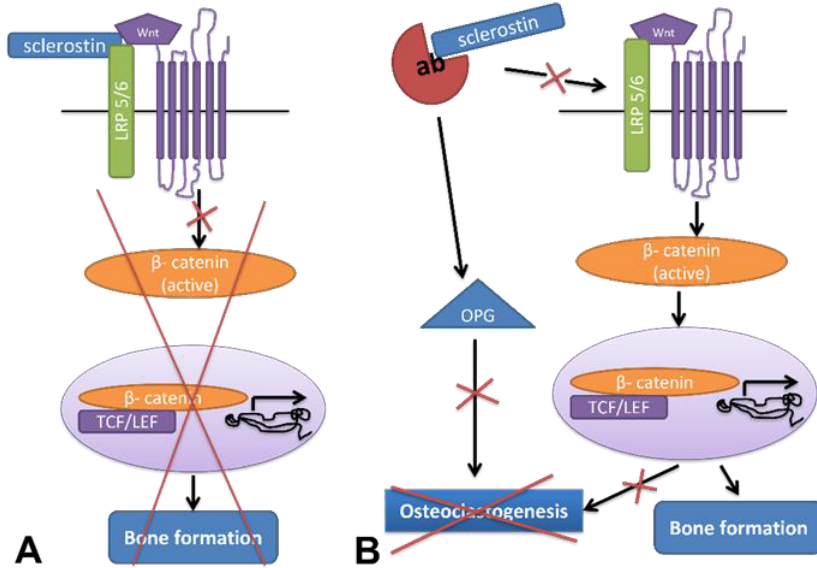
Figure 1. ( A ) Sclerostin inhibits canonical Wnt-signaling pathway through its binding to the Wnt LRP 5/6 coreceptors and leads to decreased bone formation. ( B ) When sclerostin antibody is administered, bone formation is increased through activation of Wnt signaling pathway and elevation of OPG expression, which inhibits osteoclastogenesis. LRP 5/6: low-density lipoprotein receptor-related protein 5/6, TCF: transcription factor, LEF: lymphoid enhancer-binding factor, OPG: osteoprotegerin, ab: antisclerostin antibody.